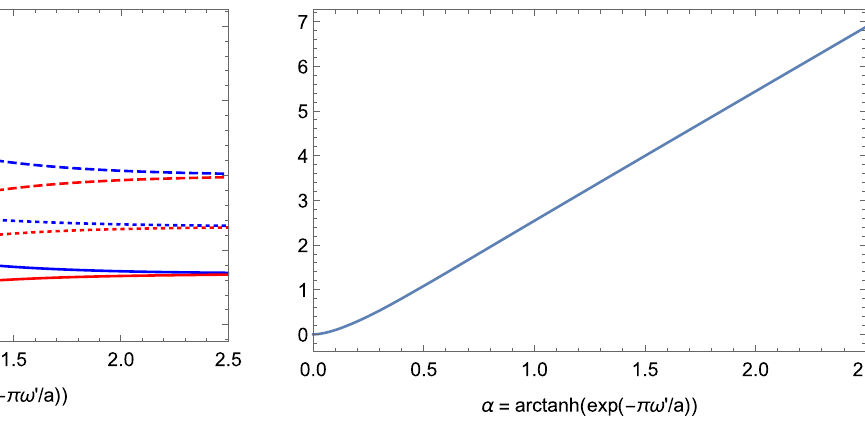
Fig. 6 States ρ M , I and ρ M , II compared–Thestate ρ M , I isdepictedby the blue lines and ρ M , II by the red lines. Classical Correlations are the solid lines, quantum discord are the dotted lines and mutual information are dashed lines